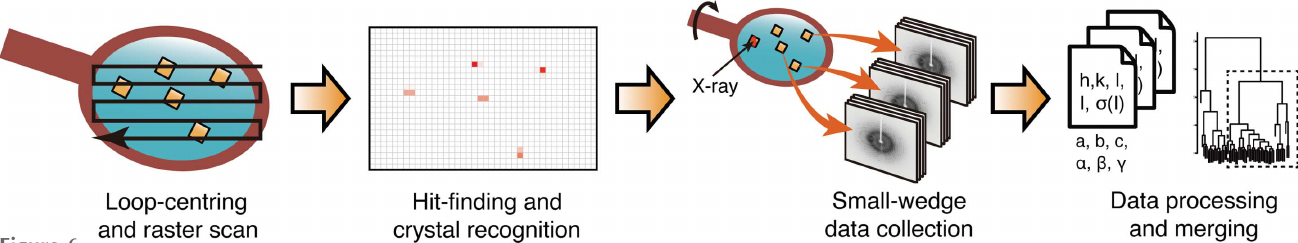
Figure 6 Automated microcrystal data-collection process. Firstly, the cryoloop is automatically centred and aligned under an optical microscope, followed by a low-dose X-ray raster scan in the defined area. The crystal positions are recognized by analyzing diffraction spots. A small-wedge diffraction dataset is collected from each crystal and processed to the merging of datasets to obtain complete and consistent